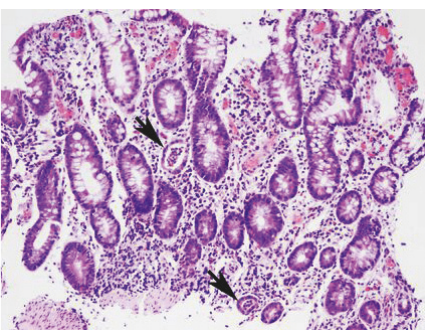
Figure 5: Histopathology with H&E shows near total loss of villi, crypt architectural distortion, and crypt abscesses (arrows) in endoscopic biopsies obtained 20 cm from anal verge, findings highly consistent with prepouch ileitis after creation of a